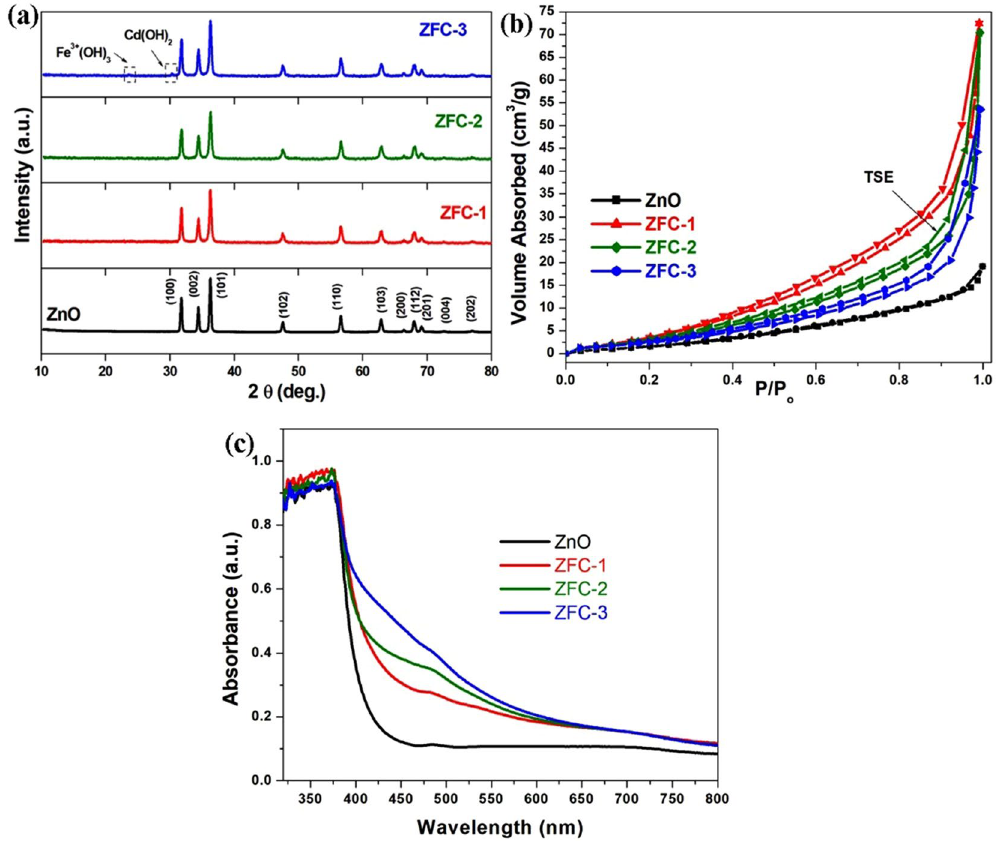
Figure 2. ( a ) X- ray diffraction patterns, ( b ) Nitrogen adsorption–desorption isotherms, and ( c ) UV-Vis absorption spectra of pure and doped ZnO